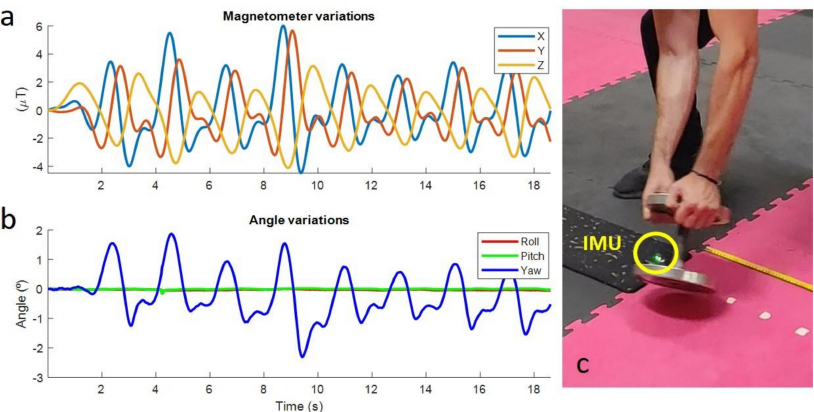
Figure 5. Dynamic perturbations. ( a ): Magnetometer variations; ( b ): Angle variations; ( c ) Experi- mental